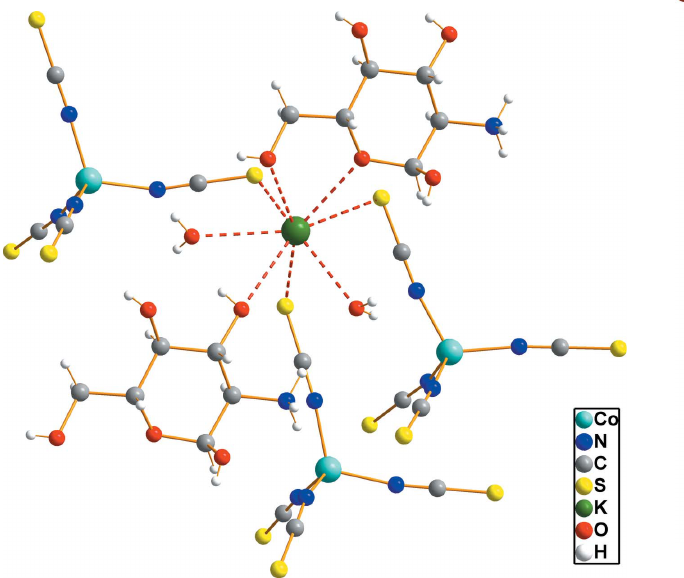
Figure 3 Hydrogen-bonding contacts between the GlcNH + cation, the (K(H 2 O) 2 ) + cation and the [Co(NCS) 4 ] 2– anion.